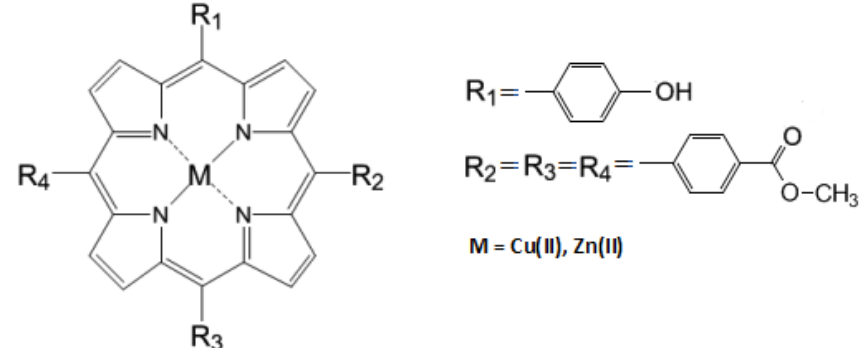
Figure 1. General structures of 5-(4-hydroxyphenyl)-10,15,20–tris-(4-carboxymethyl- phenyl)–21, 23 M(II)